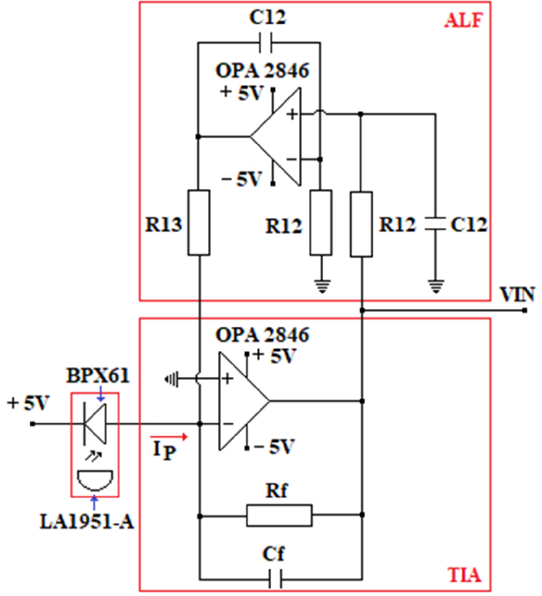
Figure 11. The electronic diagram of the TIA in tandem with the ALF filter.